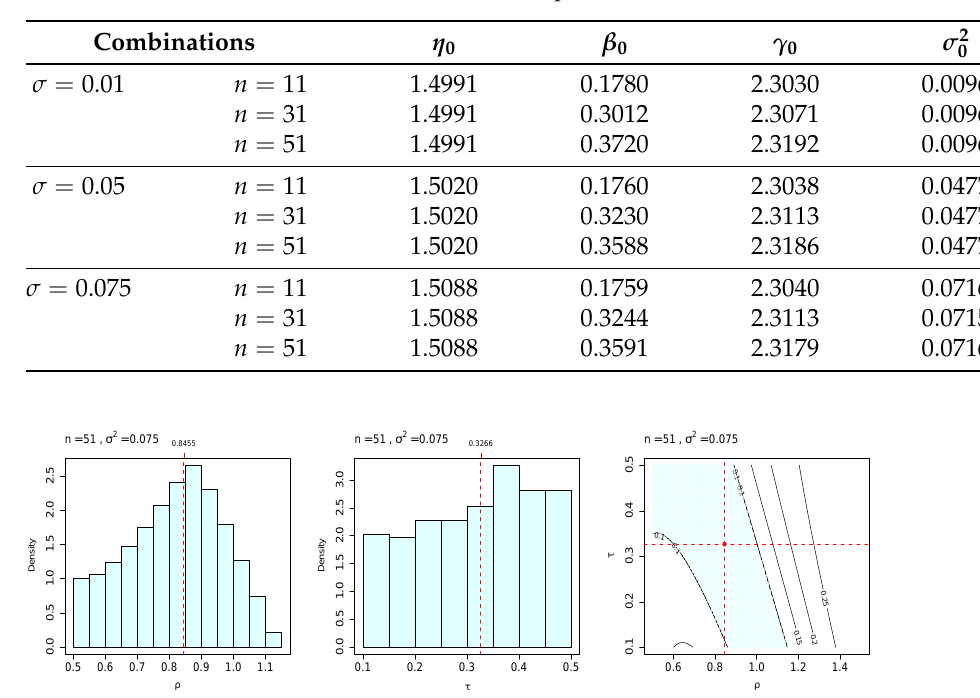
Table 4. Initial solutions for simulated data of the H 2 process.